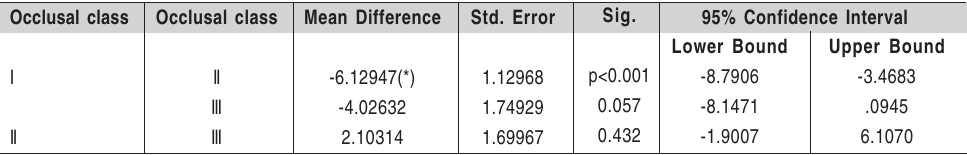
* The mean difference is significant at a level of